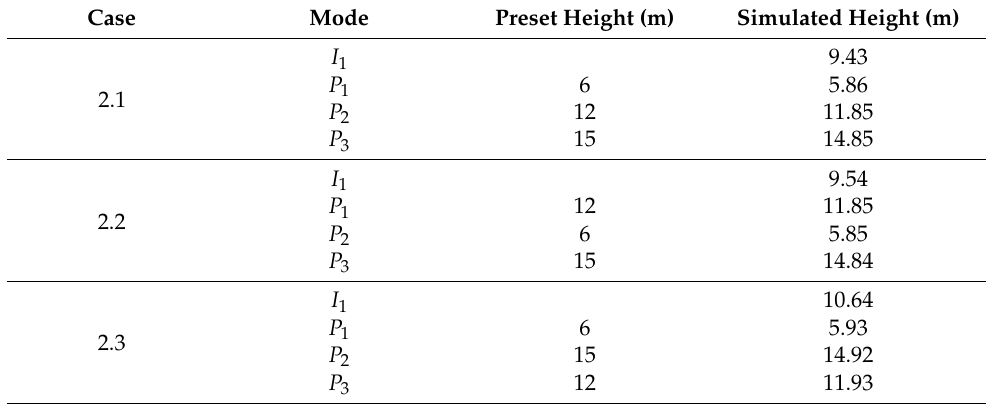
Table 3. Simulated height of mixed mechanisms.